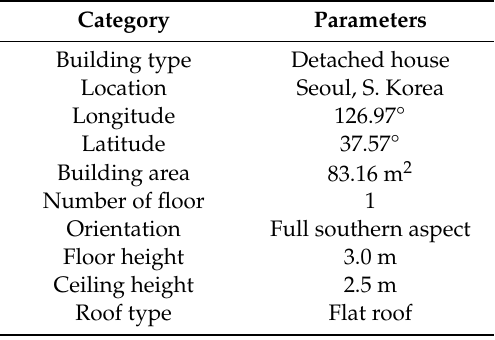
Table 1. Simulation building parameters.